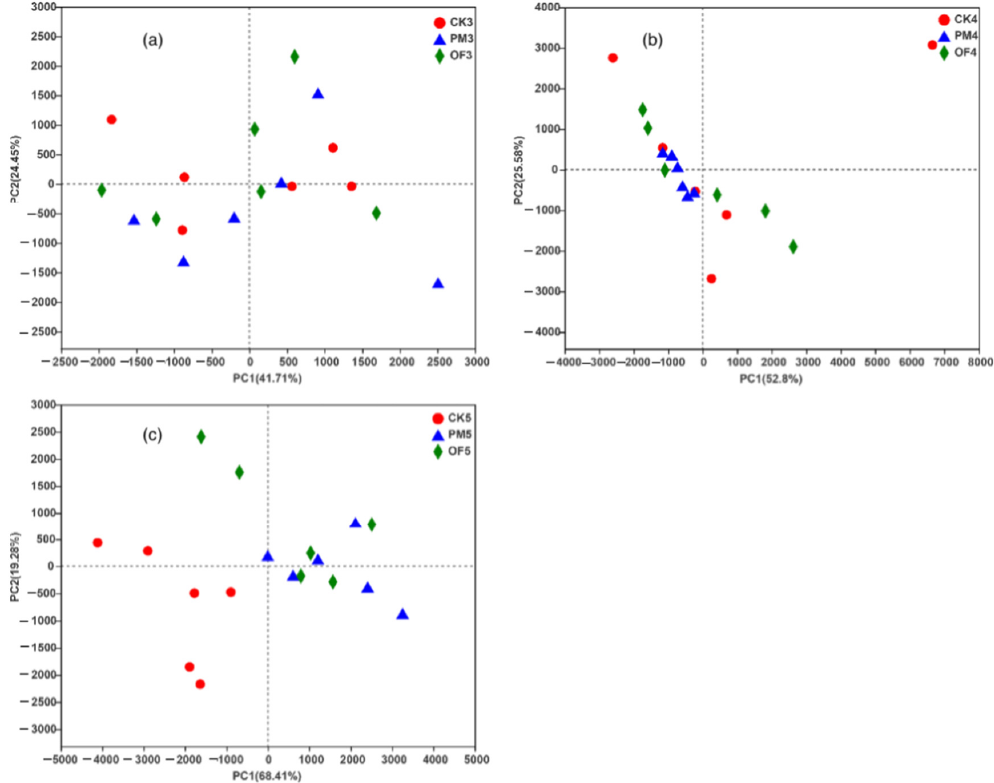
Figure 3. Redundant analysis of archaeal community phylum level: ( a ) Heading stage; ( b ) Flowering stage; ( c ) Mature stage.